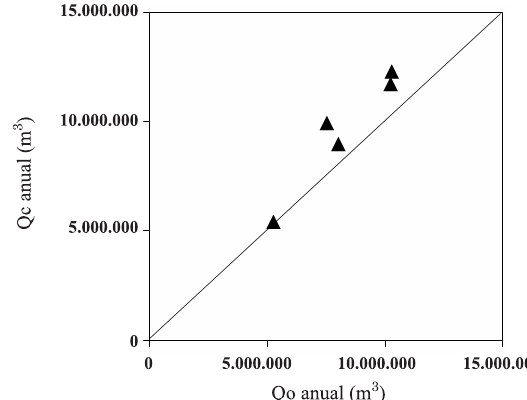
Figura 6. Valores anuais de escoamento direto observados e calculados pela equação 2 na bacia do ribeirão Pipiripau, no período de validação.